Question: According to the figure, is the described quantity increasing or decreasing?
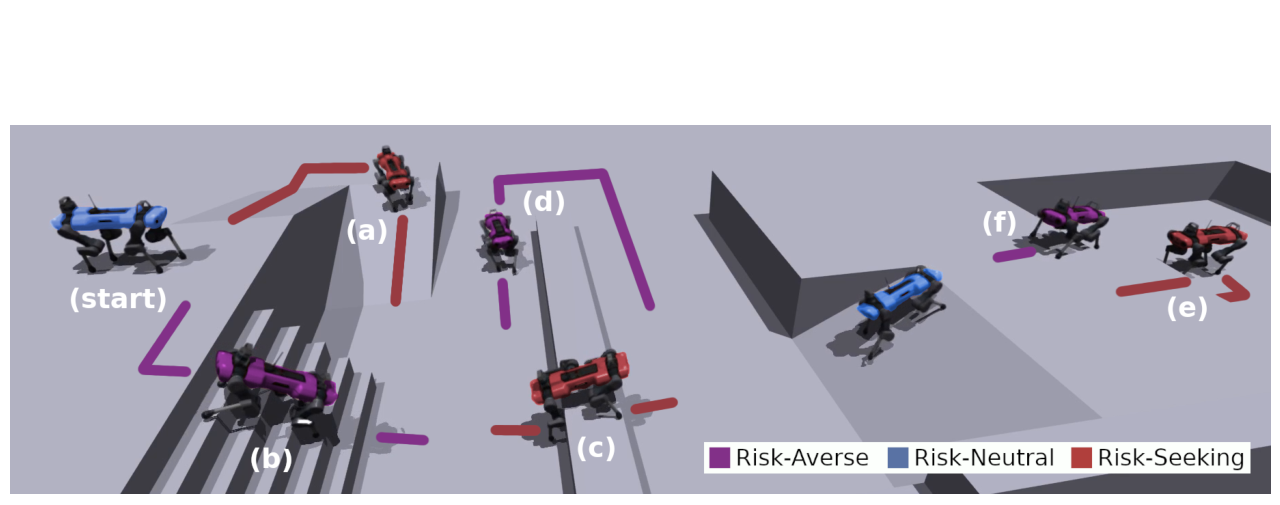
Answer: increasing